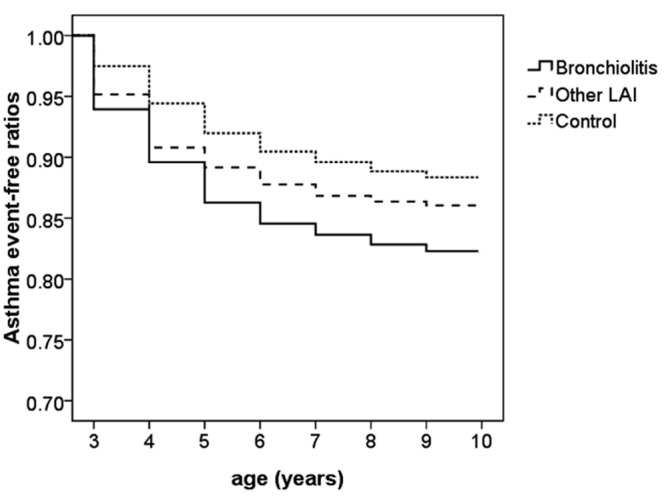
Cumulative asthma event-free rates of the enrolled children aged 3 to 10 years in different groups.Kaplan-Meier survival analysis was performed. p < 0.001 by the log rank test; p < 0.001 by the Breslow test; p < 0.001 by the Tarone-Ware test.